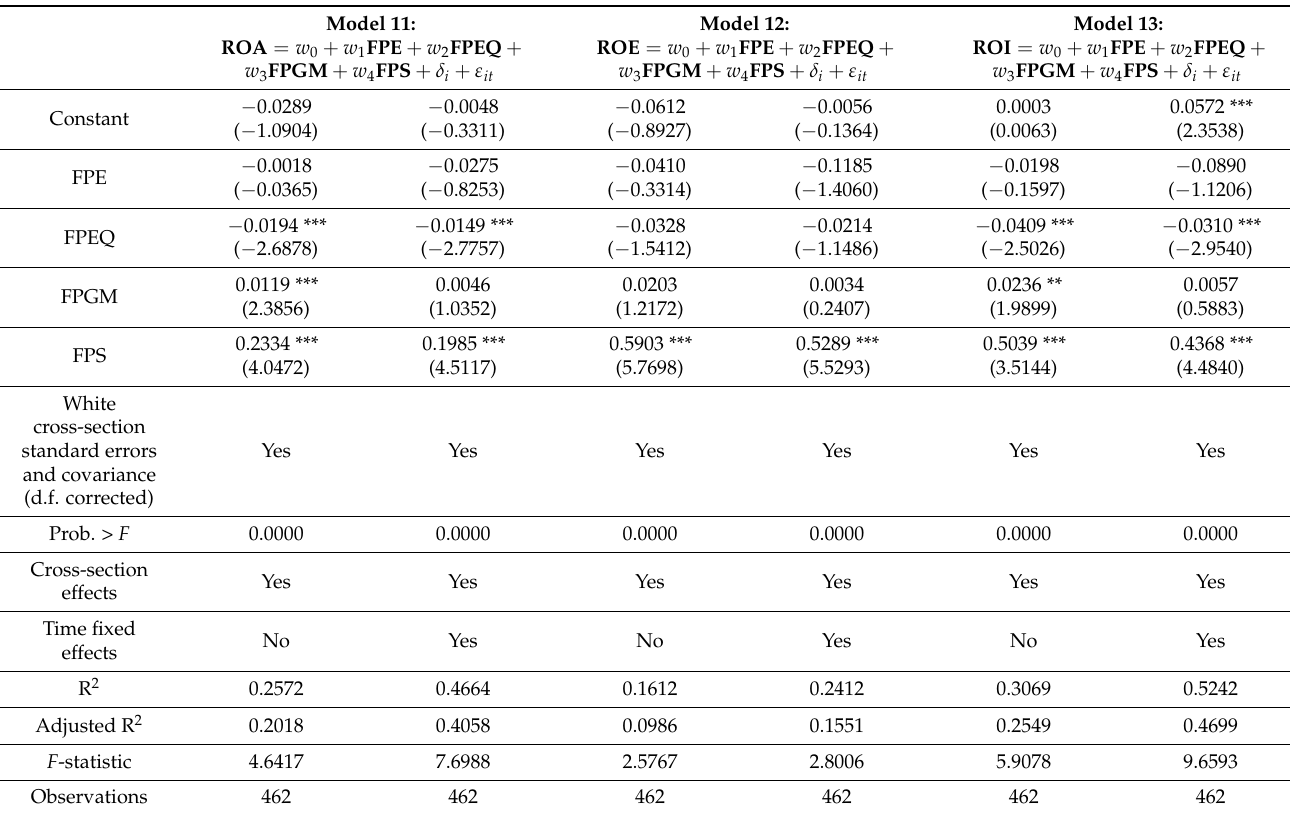
Table 11. Econometric models for oil